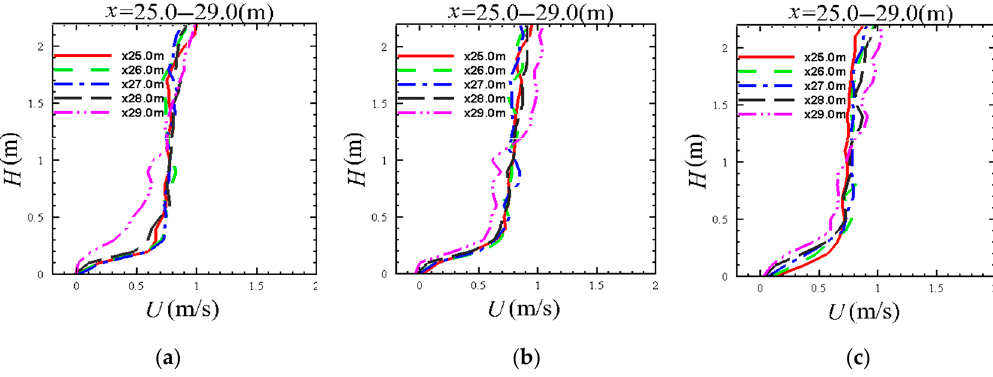
Figure 15. Longitudinal velocity distribution of the flow field in the upstream area of the pore structure when the porosity is 0.5, 0.25 and 0.125 and x = 25.0–29.0 m. ( a ) n w = 0.5; ( b ) n w = 0.25; ( c ) n w = 0.125.